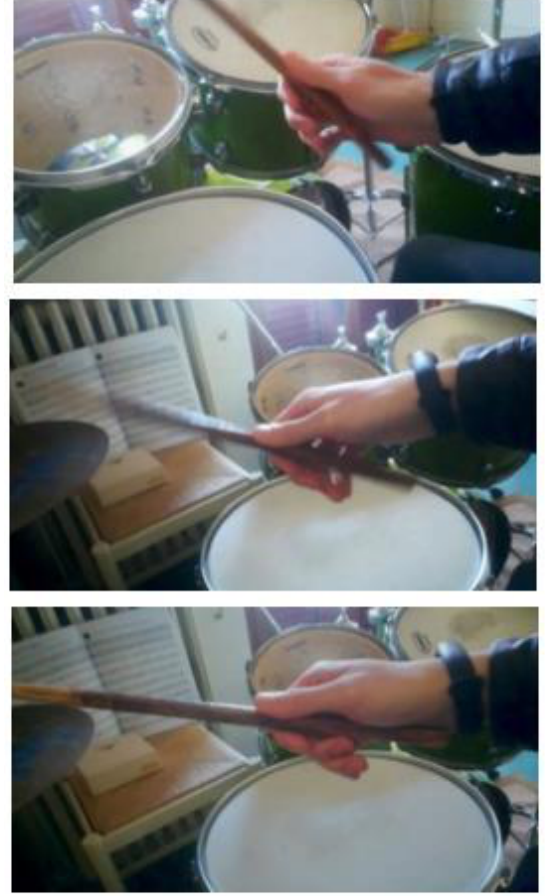
Figure 1: Movement description: the index finger and the thumb grasp the drumstick with a pliers grip constituting the fulcrum of the stick itself. Third and fourth fingers give the cadence of the rhythm and provide the greatest impact to the